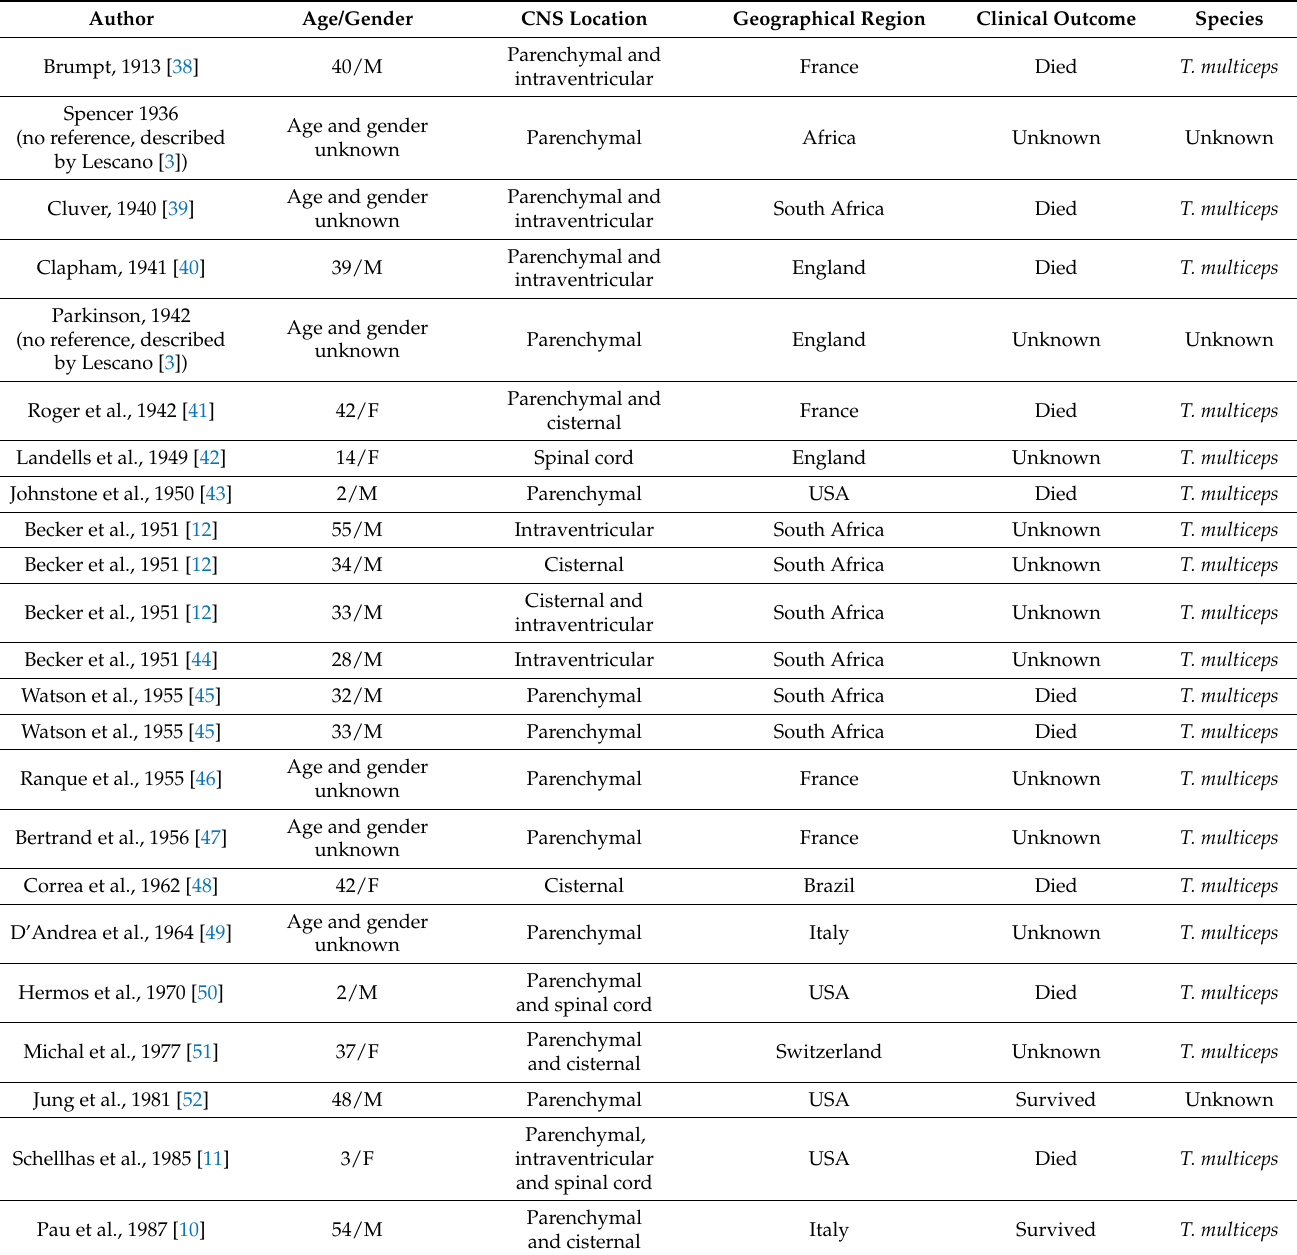
Table 1. Reported cases of human coenurosis of the central nervous